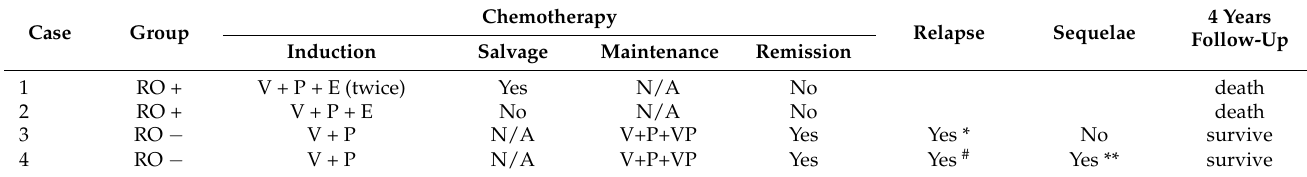
Table 3. The treatment, relapse, sequelae and final outcome of Four MS-LCH